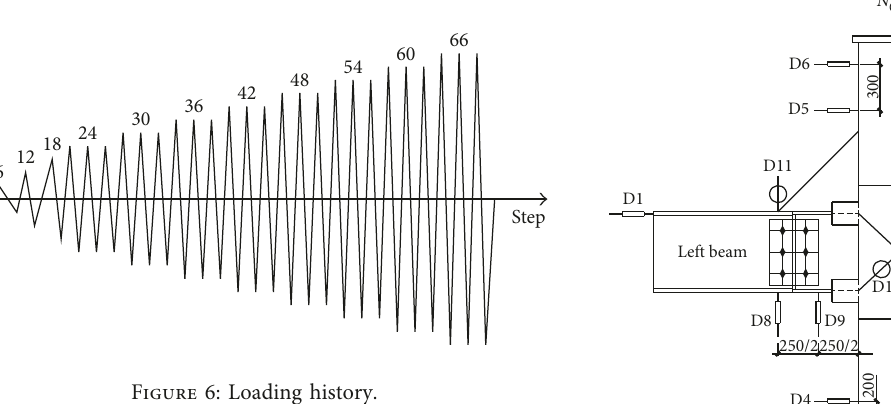
Figure 6: Loading history.